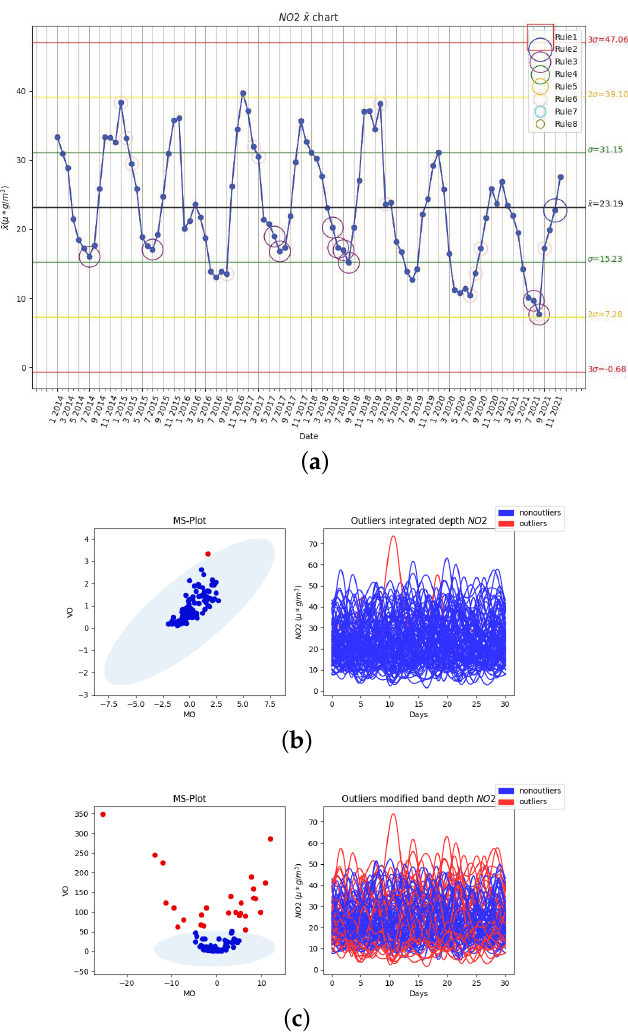
Figure 3. Results of the second phase of the NO 2 analysis: ( a ) ¯ x chart with the monthly rational subgroups and the Nelson rules implemented; ( b ) (left) Cartesian representation of the magnitude and shape outlyingness of each function with the integrated depth, (right) functional plot of the NO 2 values of each month; ( c ) (left) Cartesian representation of the magnitude and shape outlyingness of each function with the modified band depth, (right) functional plot of the NO 2 values of each